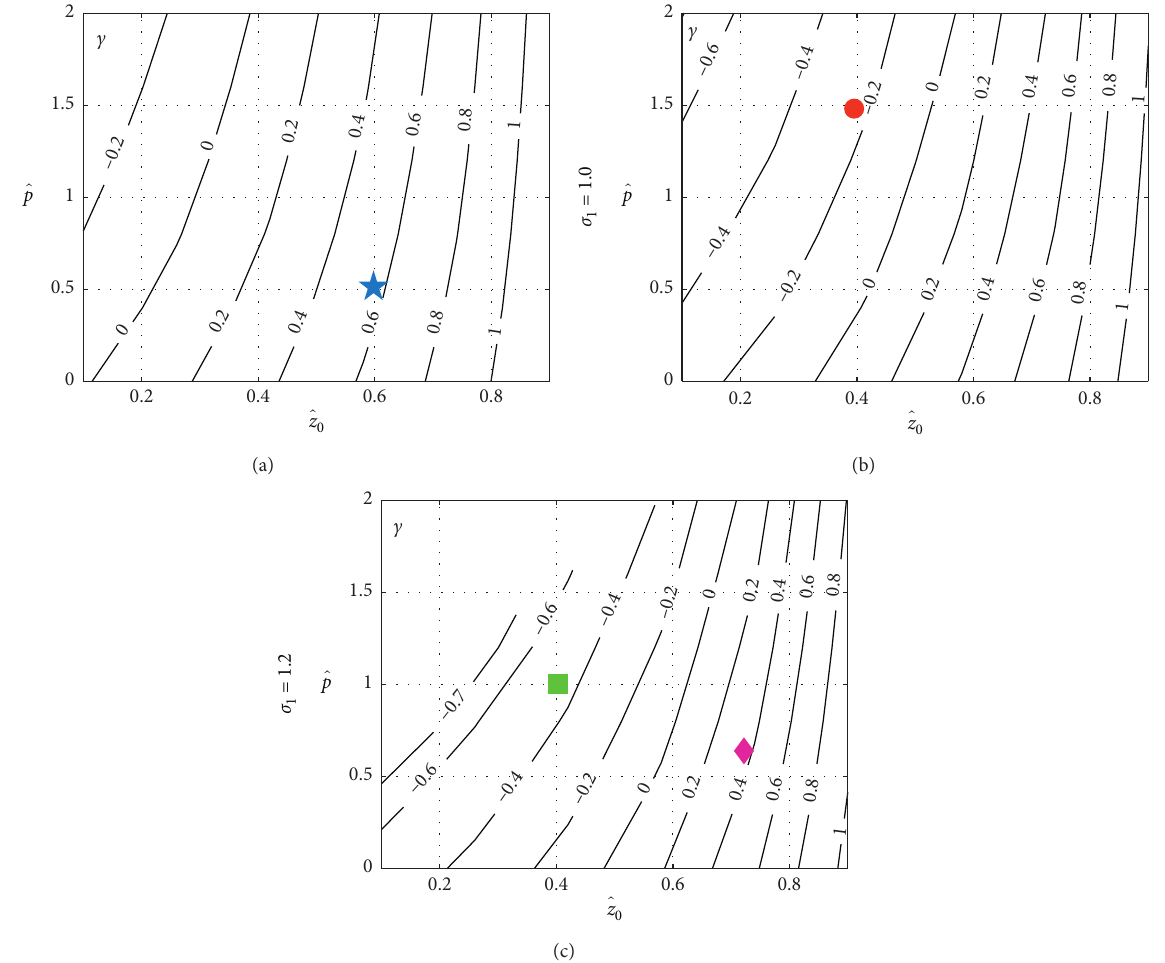
Figure 8: Contour plots for the design of an X -shaped suspension with QZS behaviour at large deflections: values of c , for different combinations of σ , 􏽢 z , and 􏽢 p 1 0